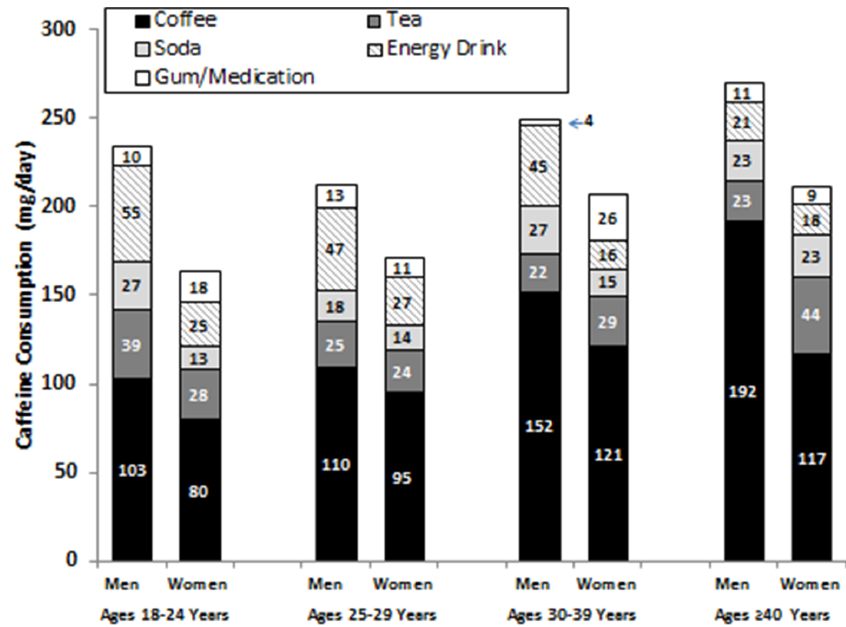
Figure 1. Daily average caffeine consumption of Navy and Marine Corps personnel.